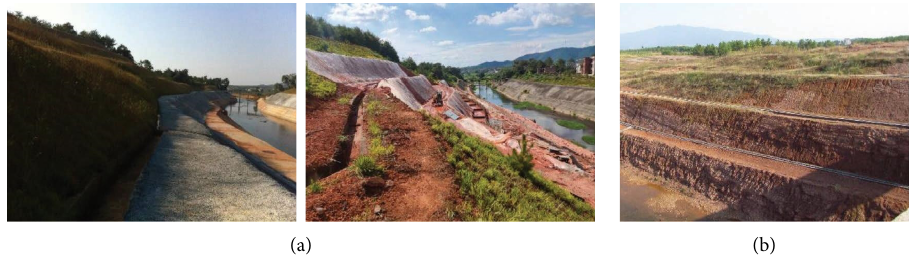
Figure 1: Slope in Zhetang diversion irrigation channel. (a) Danger removal of Gushan section (in 2014 and 2019); (b) typical channel section on the left